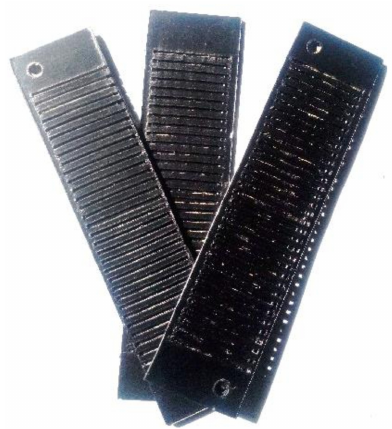
Figure 3. Three-layer bipolar plate (cathode side).